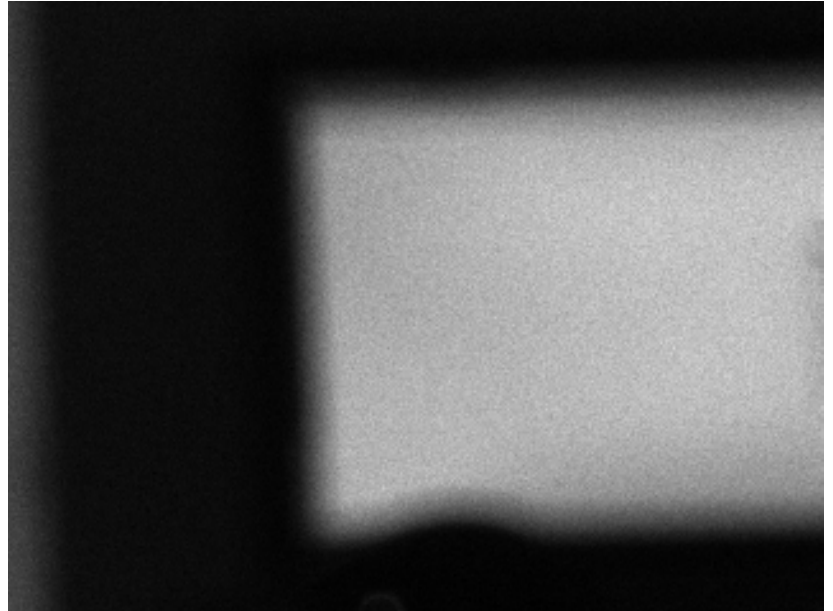
Figure 6. Sample image frame from the recorded sequence (resolution 320 × 240 with intentional lack of focus).